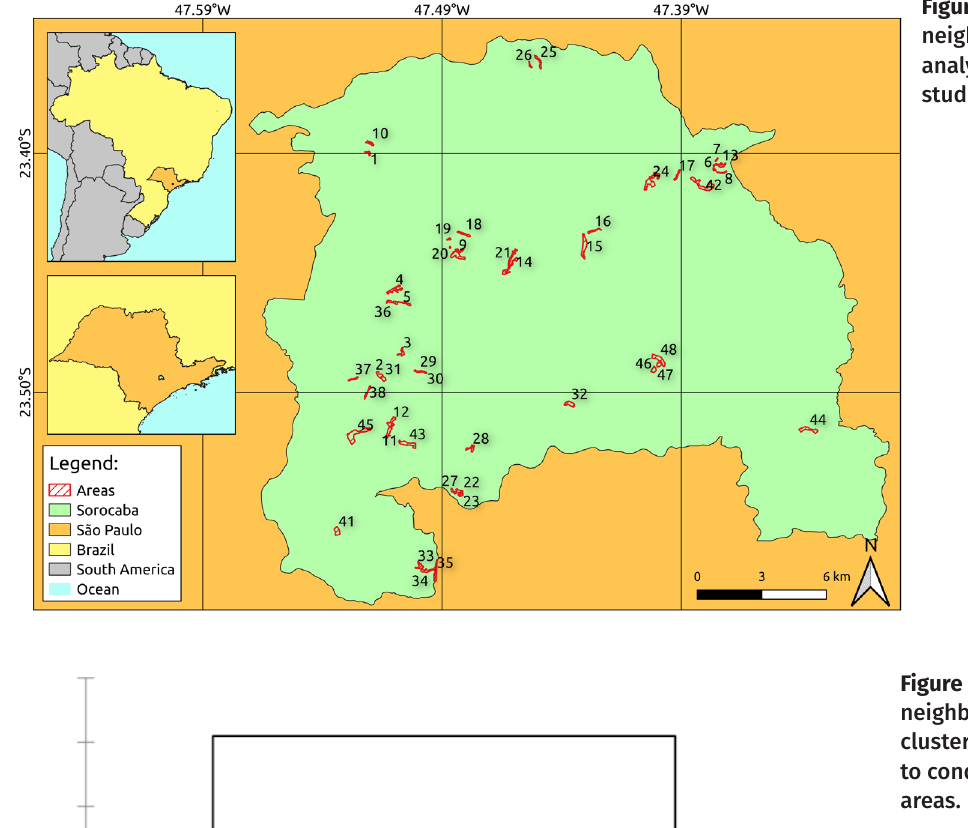
neighborhoods clustering with regard to condition of green